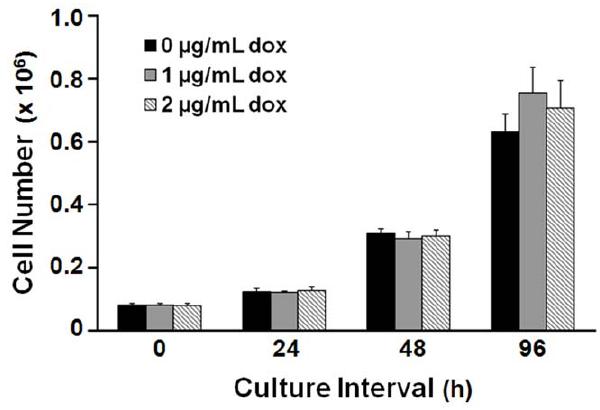
Figure 2. HeLa cell growth is not affected by doxycycline supplement. Values are the mean of three independent cultures; error bars indicate 6 1 S.E.